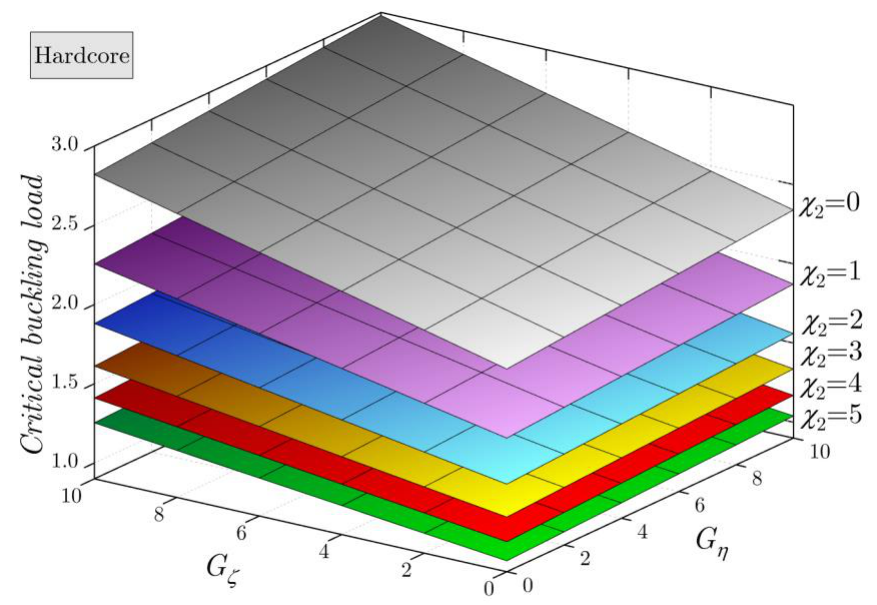
Figure 15. Effect of the orthotropic elastic foundation parameters G ζ and G η for various values of load intensity χ 2 ( SSSS , R = 5, p = k = e = 2, b = a /2 = 5 h , µ = λ = 0, θ = 0 ◦ , K w = 10 ) .